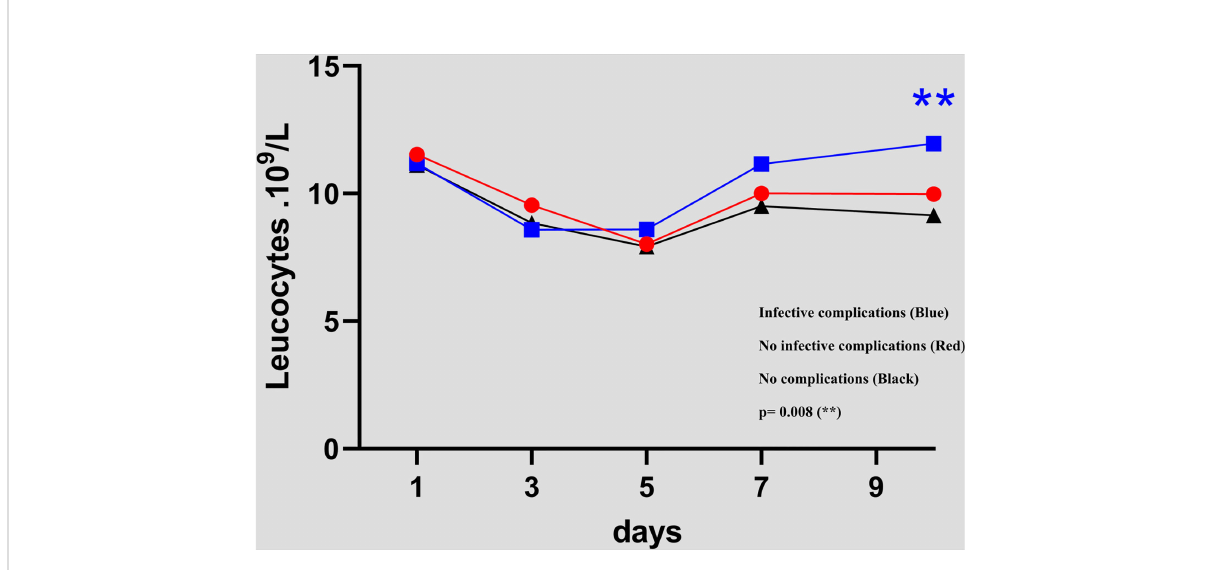
FIGURE 2 Evolution of white blood cell count between day 1 and day 10 in the 3 groups (NCs versus ICs and NCs versus NICs groups).